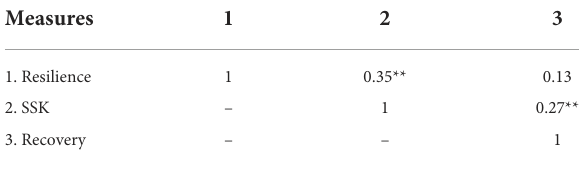
TABLE 3 Linear regression using state resilience, social skills and their interaction as predictors of recovery.